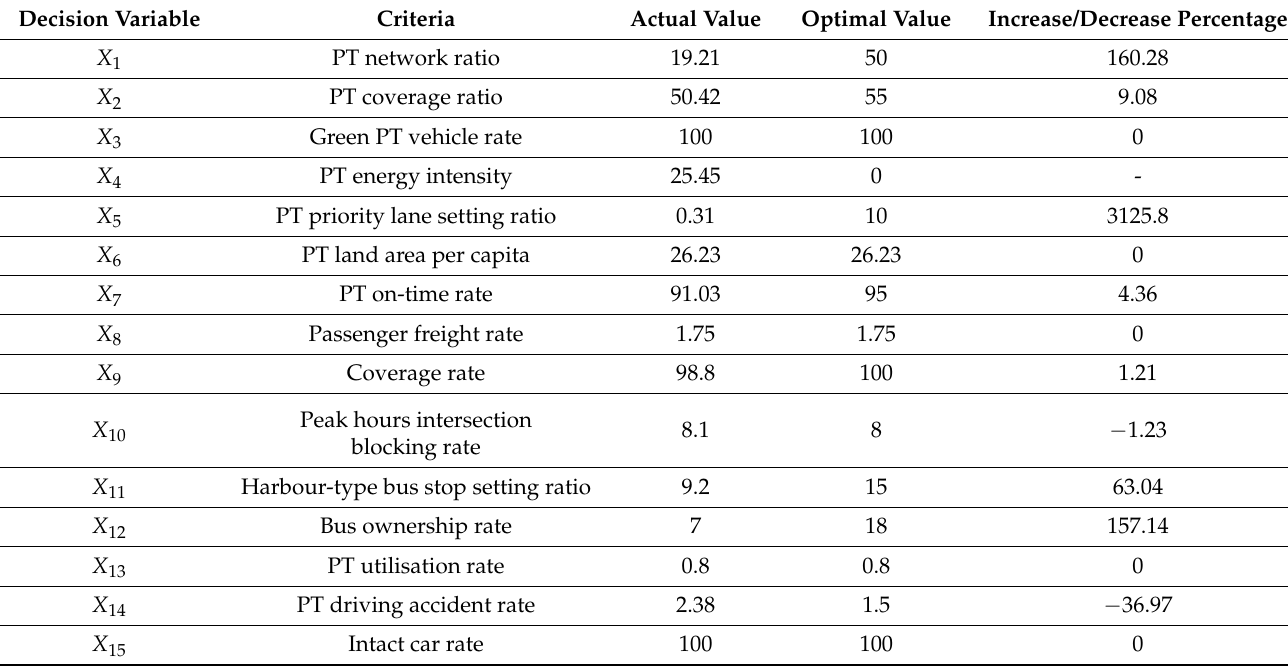
Table 5. Optimal solution for Cockburn.